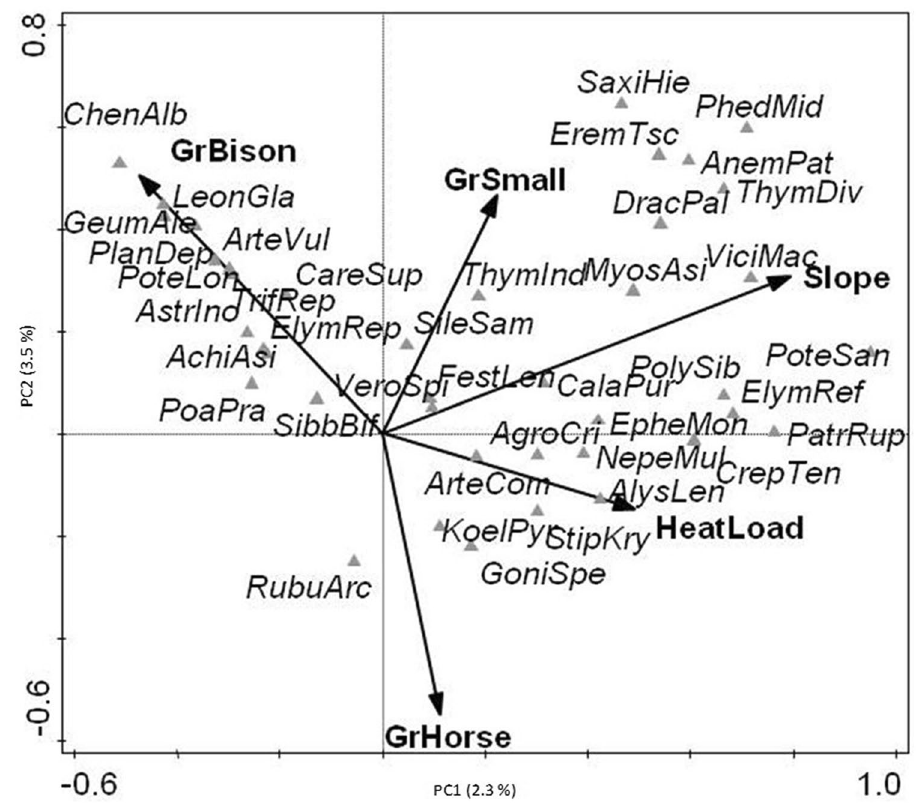
Figure 3. pCCA with macroclimate as co-variable and significant microclimate (slope inclination—Slope; heat load—HeatLoad) and grazing variables (bison—GrBison; horse—GrHorse; small mammals—GrSmall) as constraints (forward selection, 499 permutations); total inertia: 12.9, Eigenvalues: Axis1: 0.29, Axis2: 0.16; %explained variation: Axis1: 2.4, Axis2: 1.3; only most abundant species used and 40 best fitted species shown; species cover square root-transformed.